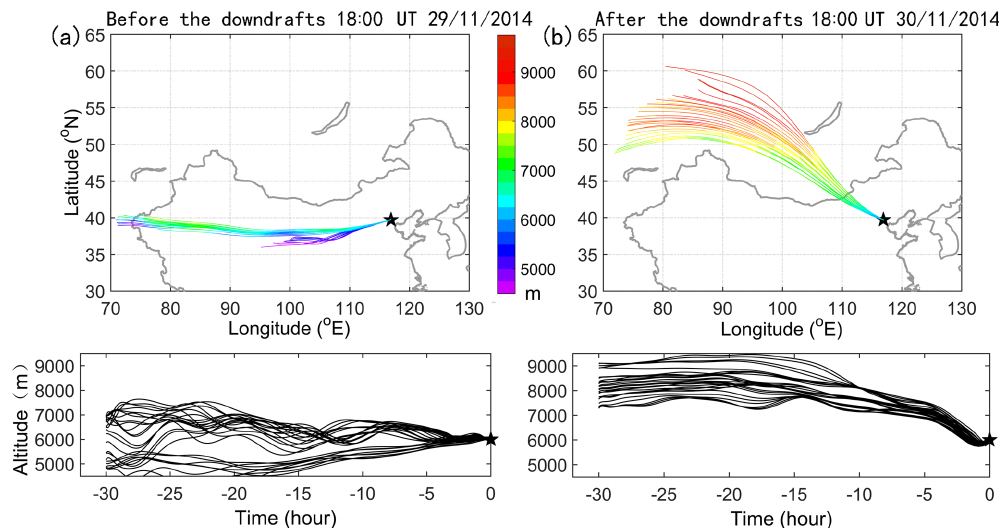
Figure 9. Illustration of 30h three-dimensional backward trajectories ending at Xianghe at 6000m using the National Oceanic Atmospheric Administration (NOAA) HYSPLIT model: (a) before the main downdrafts at 18:00UTC on 29 November 2014, and (b) after the main downdrafts at 18:00UTC on 30 November 2014. The HYSPLIT ensemble consists of 27 trajectories. The upper plots show the horizontal projection of the trajectories, and the lower plots show the corresponding time–height vertical displacement of the trajectories.